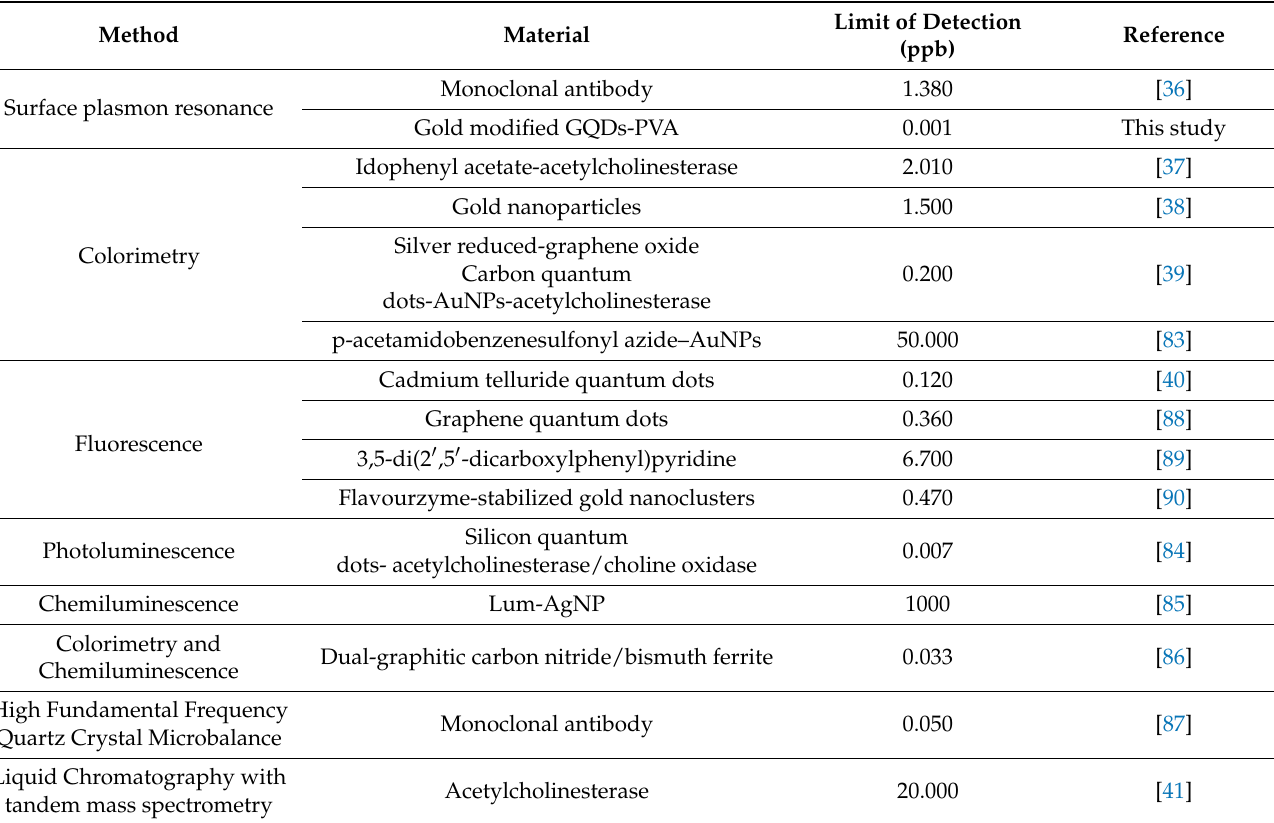
Table 2. The resonance angle and shift of resonance angle for the detection of various concentrations of carbaryl (0 − 0.08 ppb).